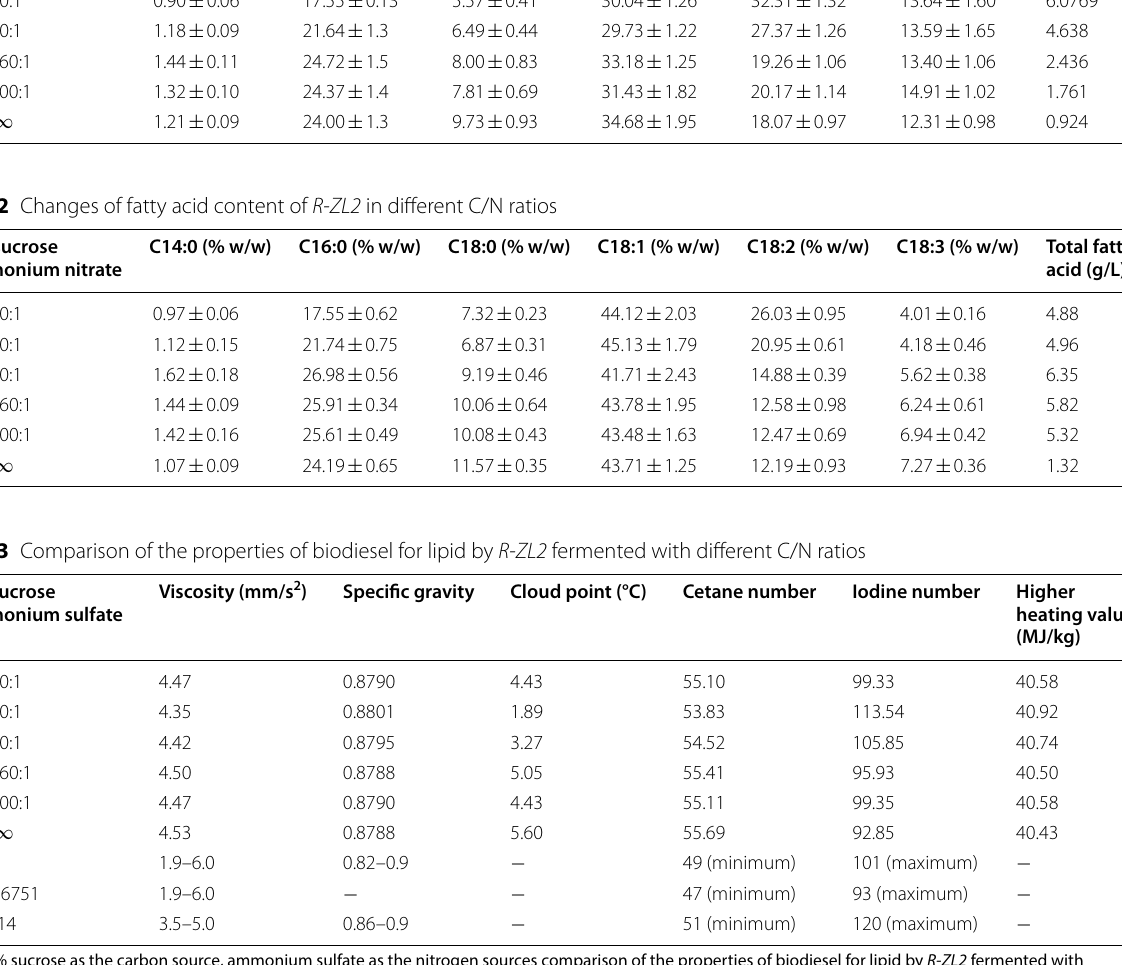
When 4% sucrose as the carbon source, ammonium sulfate as the nitrogen sources comparison of the properties of biodiesel for lipid by R-ZL2 fermented with different C/N ratios with those of Chinese, U.S. and EU biodiesel